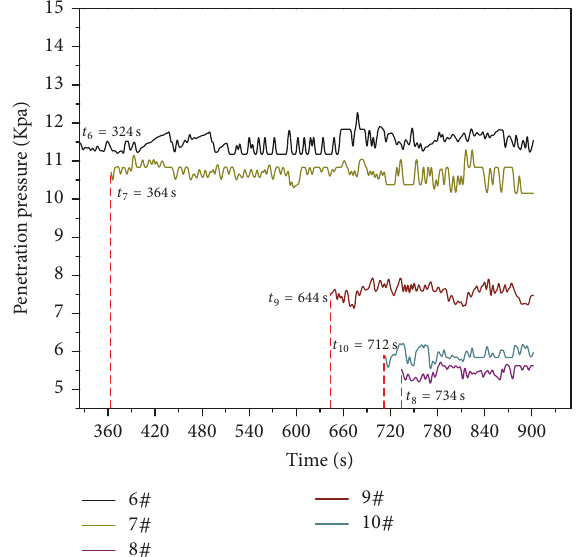
Figure 3: The change of penetration pressure over time from monitoring points